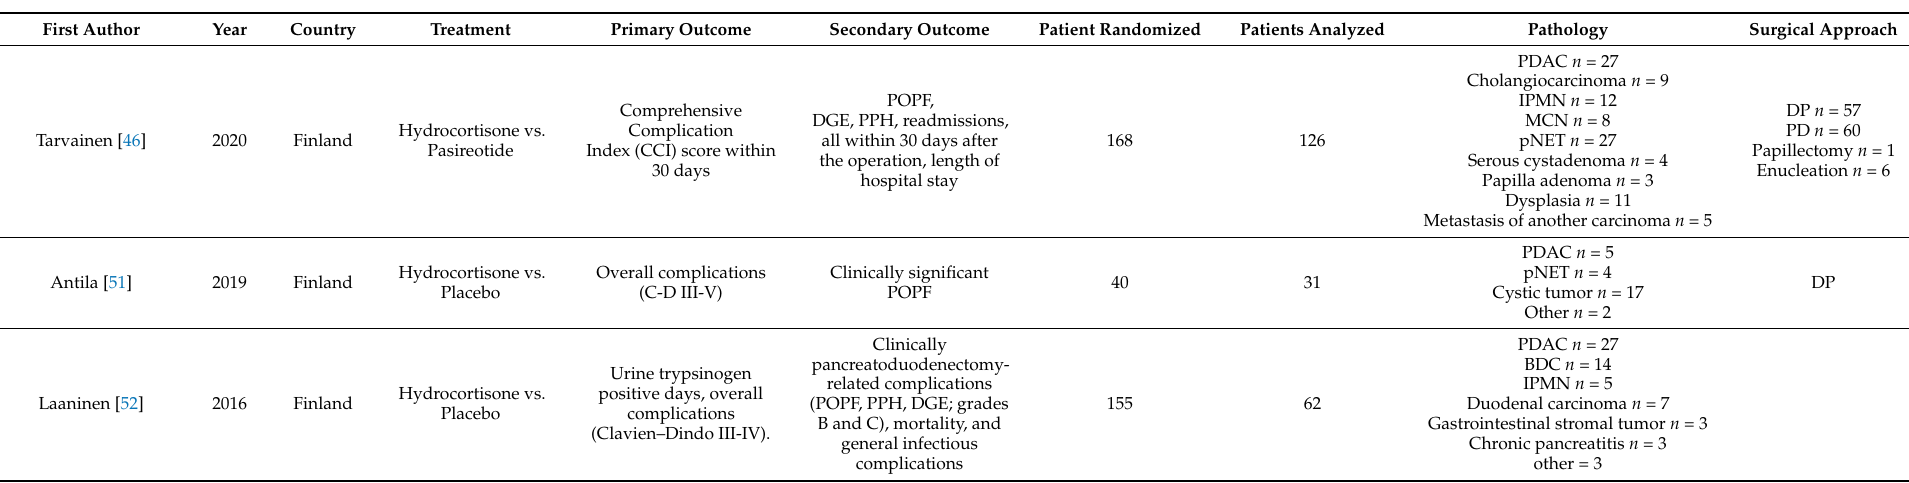
Table 2. Corticosteroids.